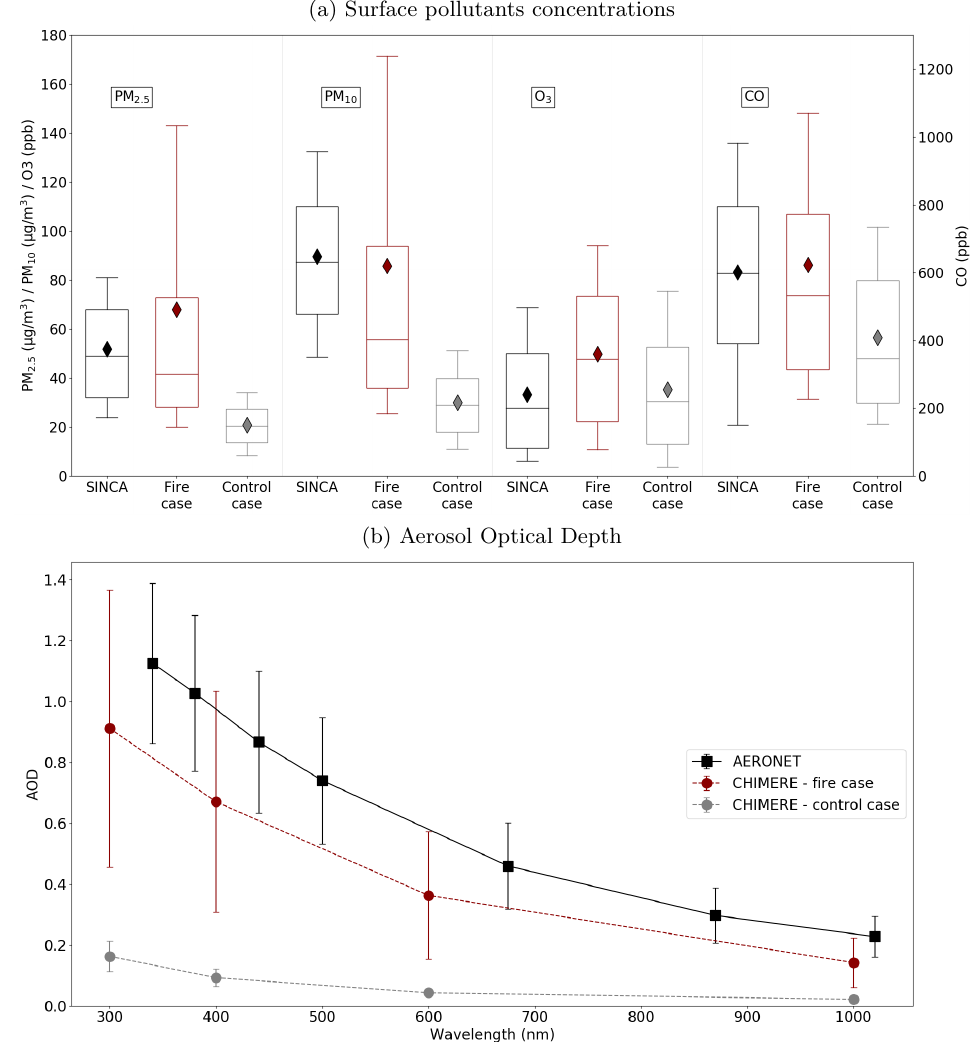
Figure 2. ( a ) Observed (black), and modeled (fire case in red, control case in gray) distribution of surface pollutants hourly concentrations in Santiago between 22 and 30 January. Distribution over 9 stations of the SINCA network (Parque O’Higgins, Las Condes, Independencia, Puente Alto, Pudahuel, La Florida, El Bosque, Cerrillos, Quilicura). Boxes show the median and first and third quartile, whiskers show 10% and 90% percentiles, diamonds show the mean. ( b ) AOD distribution by wavelength for the period 22 to 30 January for Santiago Beauchef AERONET station (same color code). Whiskers show one standard